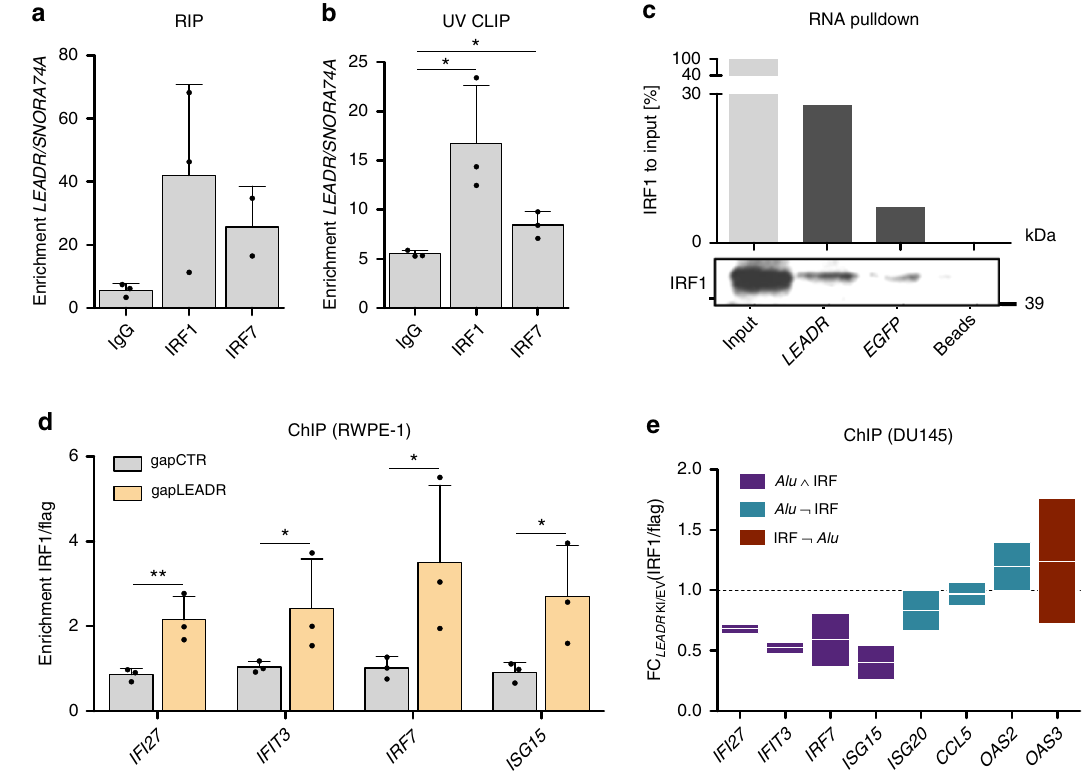
Fig. 9 LEADR interacts with IRF1 protein and modulates its occupancy on promoters. a qRT-PCR reporting enrichment of LEADR transcript (normalized to SNORA74A ) in immunoprecipitants from RIP experiments conducted using the indicated antibodies. Mean + s.d. plotted. b qRT-PCR reporting enrichment of LEADR transcript (normalized to SNORA74A ) in immunoprecipitants from UV-CLIP experiments conducted using the indicated antibodies. Mean + s.d. ( n = 3) plotted. c Western blot showing enrichment of IRF1 protein (as quanti fi ed in the above plot) upon RNA pulldown performed using biotinylated in vitro transcribed LEADR . Biotinylated in vitro transcribed EGFP and beads only were used as controls. Representative blot out of three independent experiments. d ChIP-qPCR detection of IRF1 occupancy on representative target loci upon LEADR silencing in RWPE-1 cells, expressed as IRF1/ fl ag ratio normalized to unrelated genomic region. Mean + s.d. ( n = 3) plotted. e ChIP-qPCR detection of IRF1 occupancy on representative target loci upon ectopic LEADR overexpression in DU145 cells. Data are expressed as fold change (FC) of IRF1/ fl ag ratio normalized to unrelated genomic region in overexpressing cells compared to EV. Line at mean plotted ( n = 3). ∗ p < 0.05, ∗∗ p < 0.01 (Student ’ s t test). Source data are provided as a Source Data fi le, together with